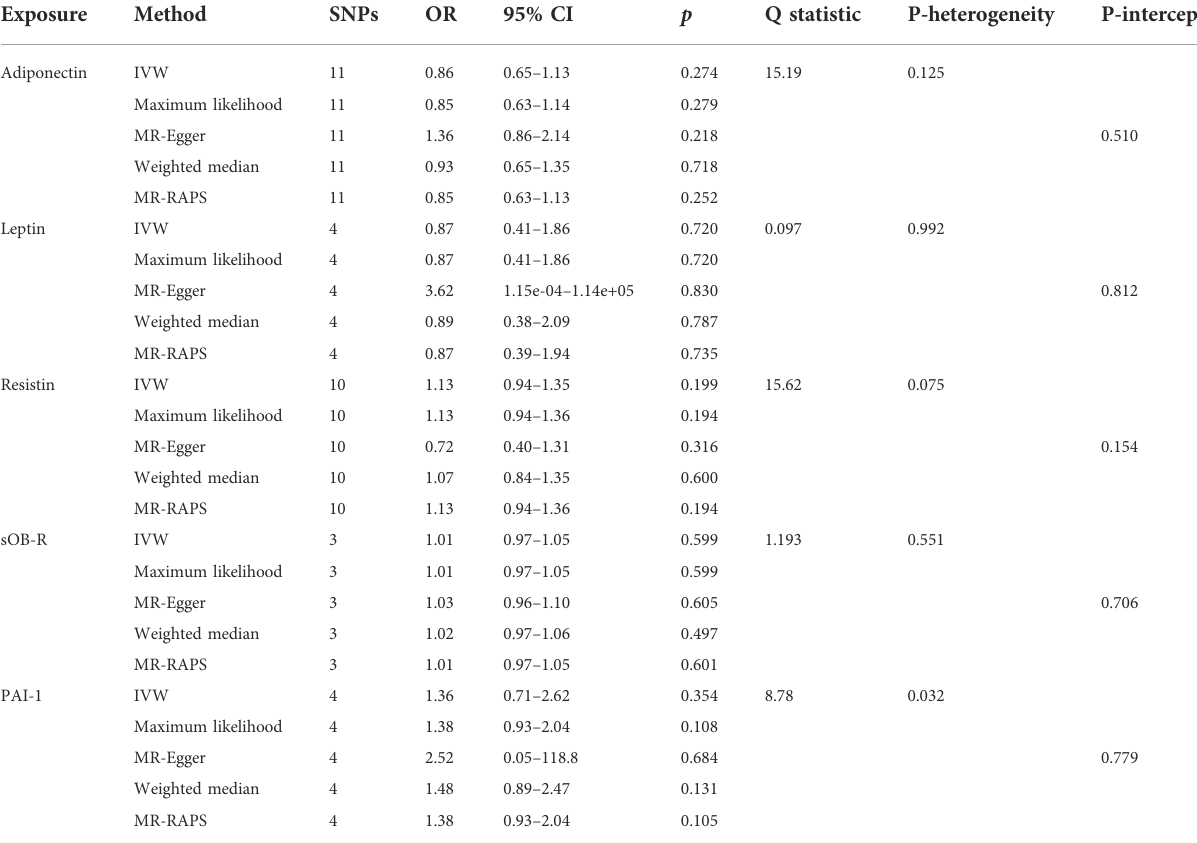
TABLE 2 Two-sample MR estimates of associations between genetically predicted circulating adipokine levels and PET.